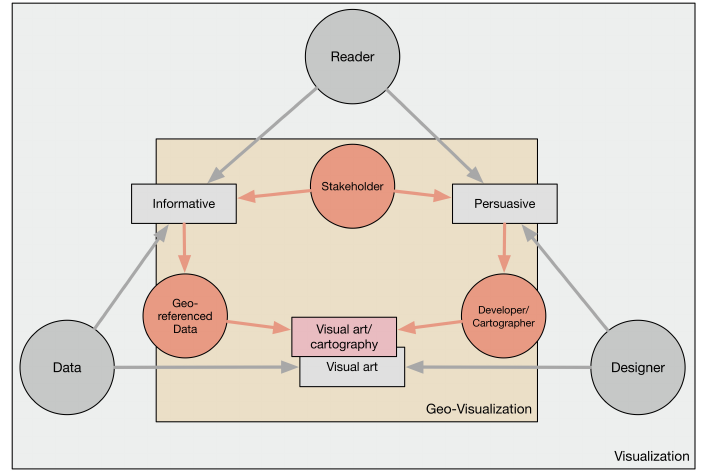
Figure 2. The Iliinsky and Steele’s three-legged stool model (in gray) and their conceptual evolution for spatially related data (in orange).